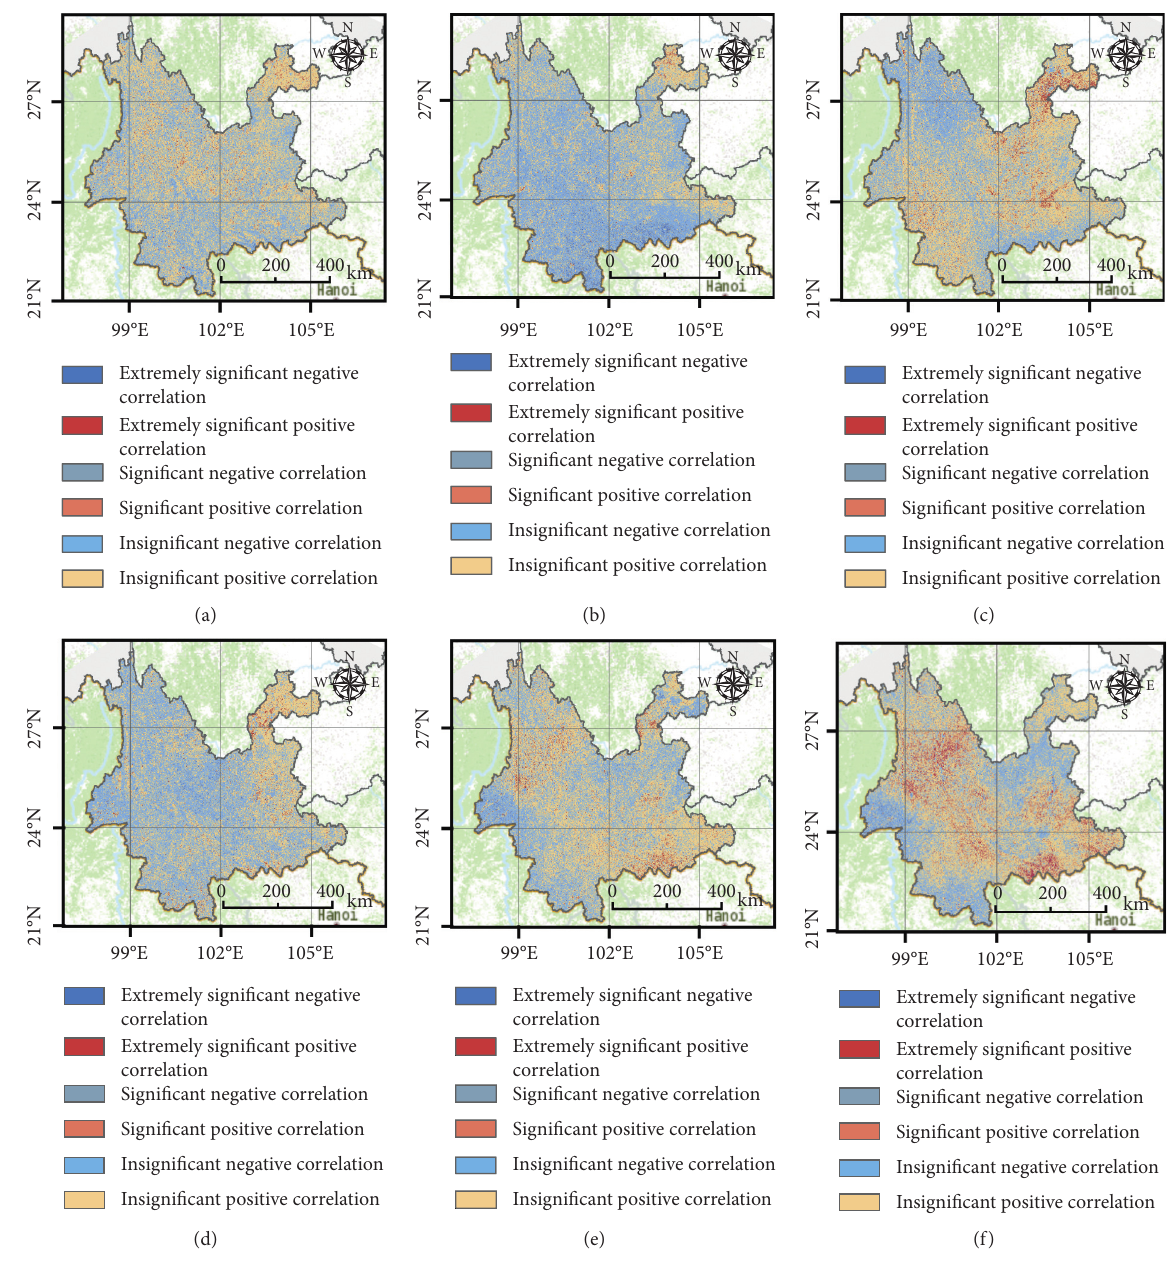
Figure 10: Spatial distributions of correlation coefficients between NDVI and precipitation or temperature in different seasons. The spatial distribution of correlation coefficients (a) between spring precipitation and summer NDVI; (b) between spring precipitation and autumn NDVI; (c) between summer precipitation and autumn NDVI; (d) between spring temperature and summer NDVI; (e) between spring temperature and autumn NDVI; (f) between summer temperature and autumn